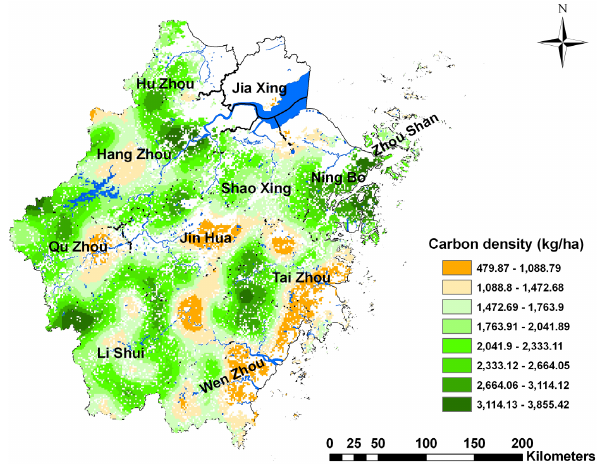
Fig. 7. Spatial distribution map of FLC Fig. 7 Spatial distribution map of FLC density.